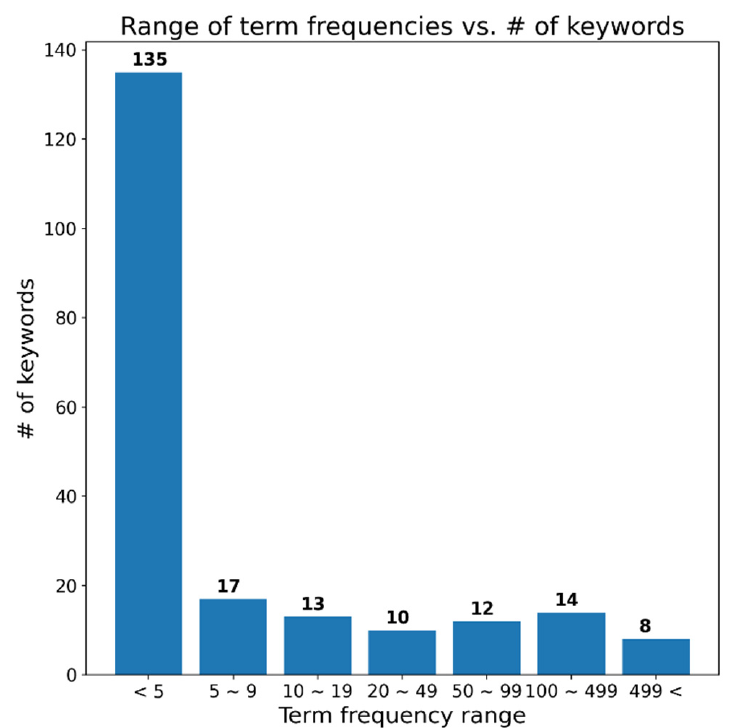
Figure 2. The number of extracted keywords with respect to their frequencies.